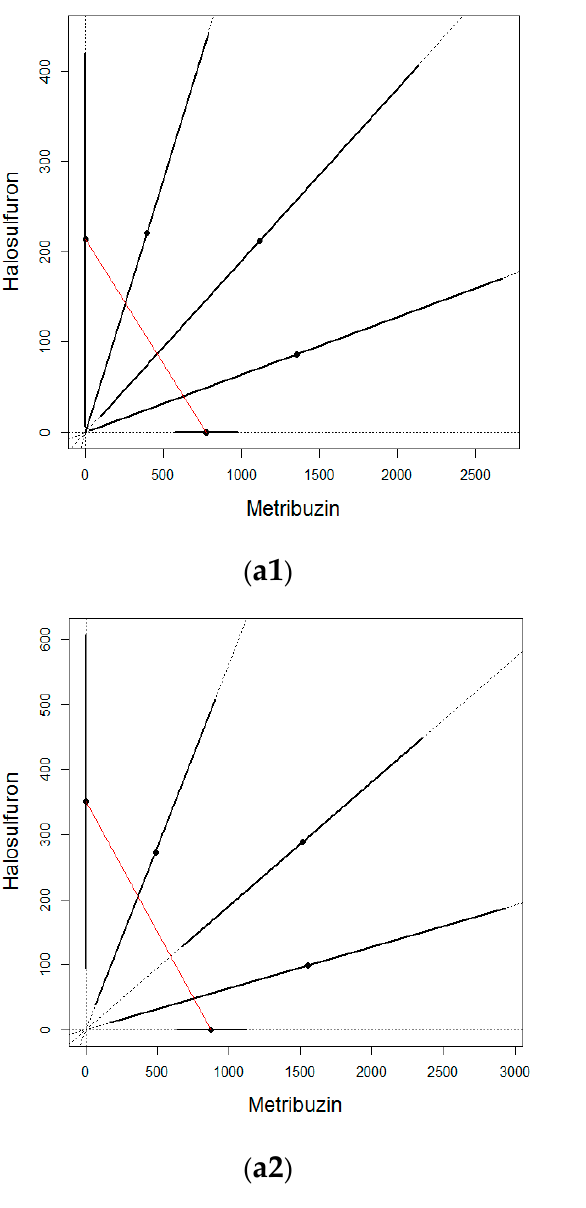
Figure 3. ED 50 isobologram show the interactions of metribuzin:halosulfuron ( a ) and metribuzin:flumioxazin ( b ) on potato fresh weight in first experiment ( 1 ) and second experiment ( 2 ). The straight line of isobologram indicates additivity. The lines around the mixture points are 95% confidence intervals.